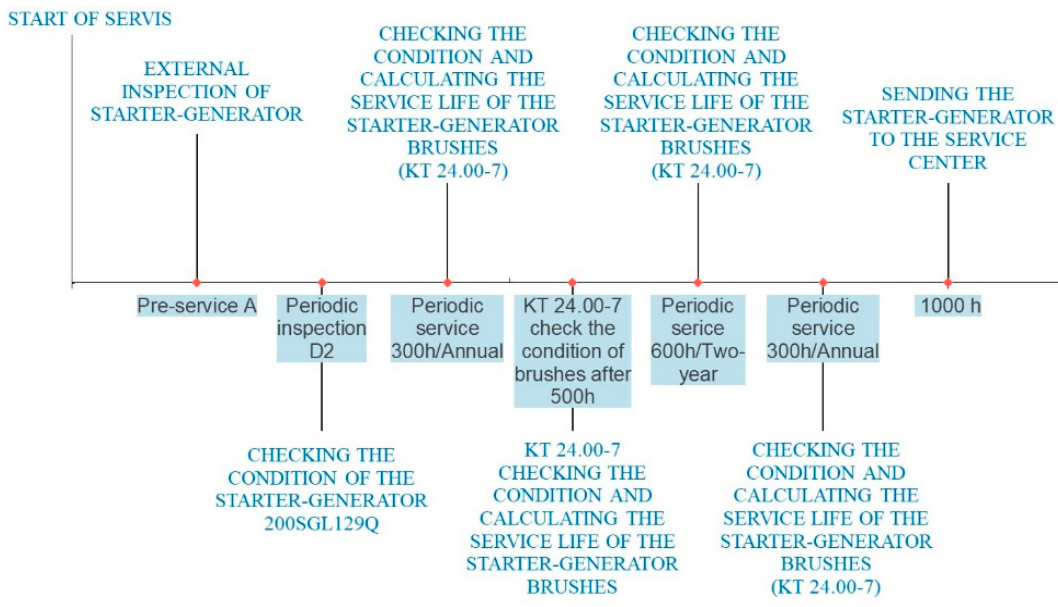
Figure 2. Operational process of the 200SGL120Q starter-generator.